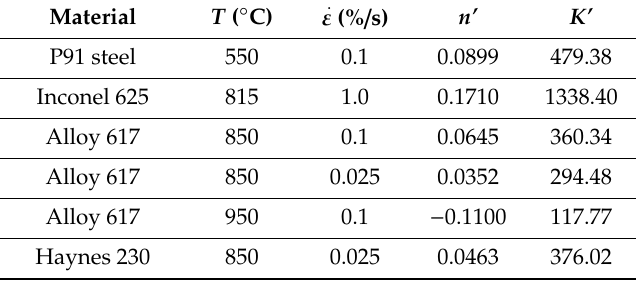
Figure 4. The cyclic stress strain relation of Inconel 625 at 815 °C.